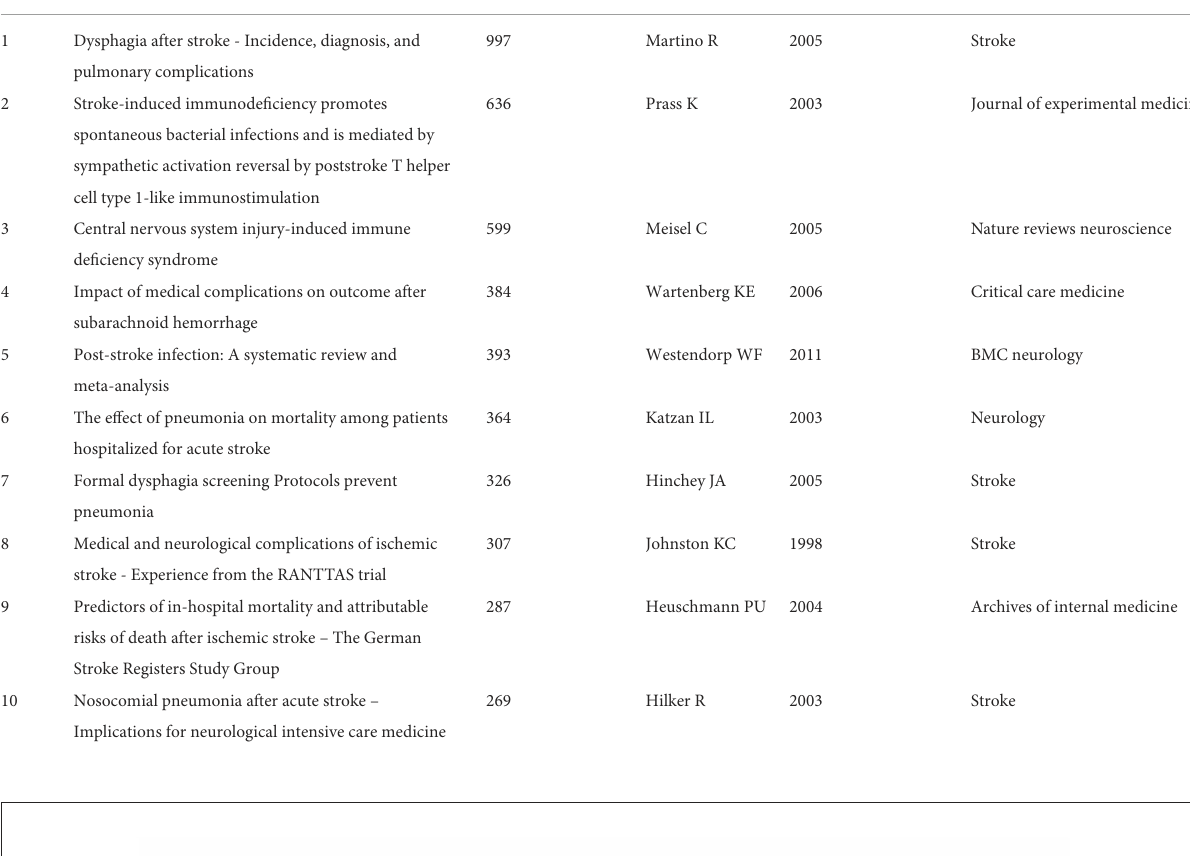
TABLE 5 The top 10 articles with the most citations in the field of post-stroke pneumonia.